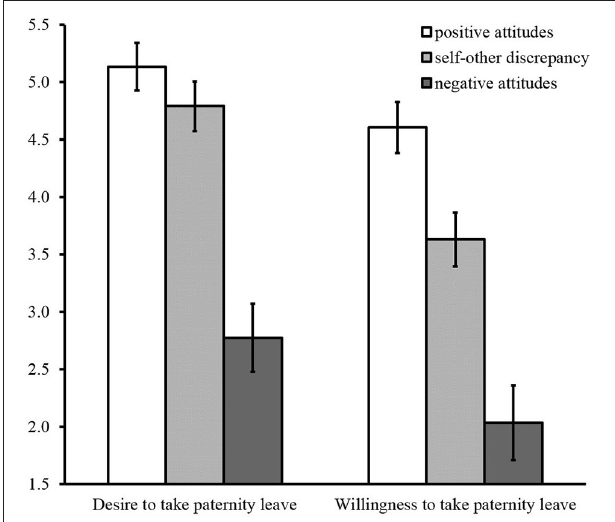
FIGURE 2 | Means of behavioral intentions by group in Study 2 (error bars are 95% confidence intervals).